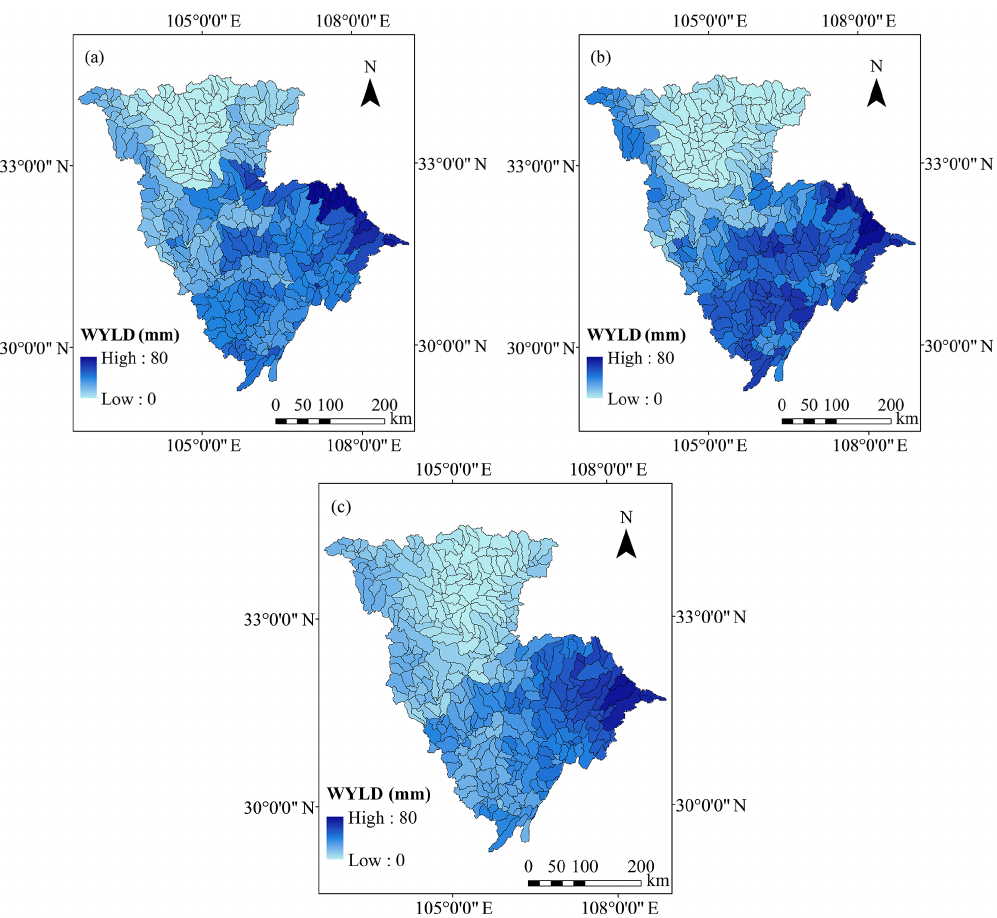
Figure 10. Spatial variation of water yield at a monthly scale for all subbasins calculated with precipitation inputs of (a) Gauge, (b) CHIRPS, and (c)